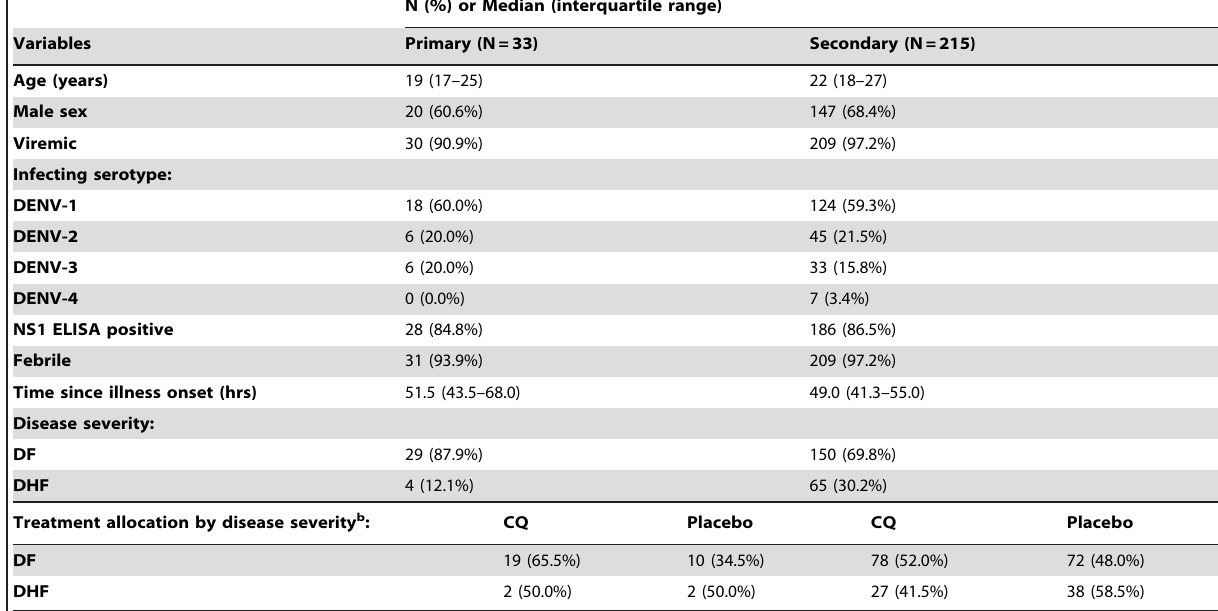
Table 1. The characteristics of the study population a